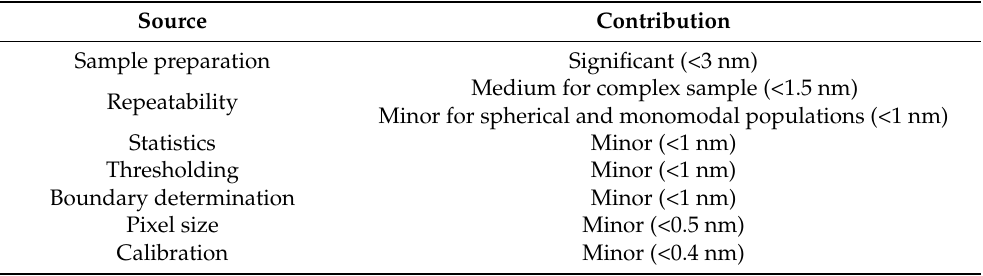
Table 2. Sources of the uncertainty budget for NP size measurements by